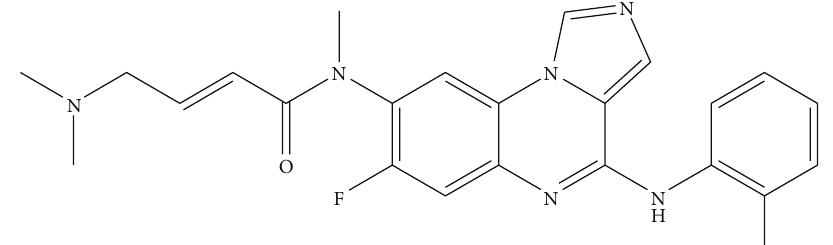
Figure 21: Chemical structure of compound 56 .